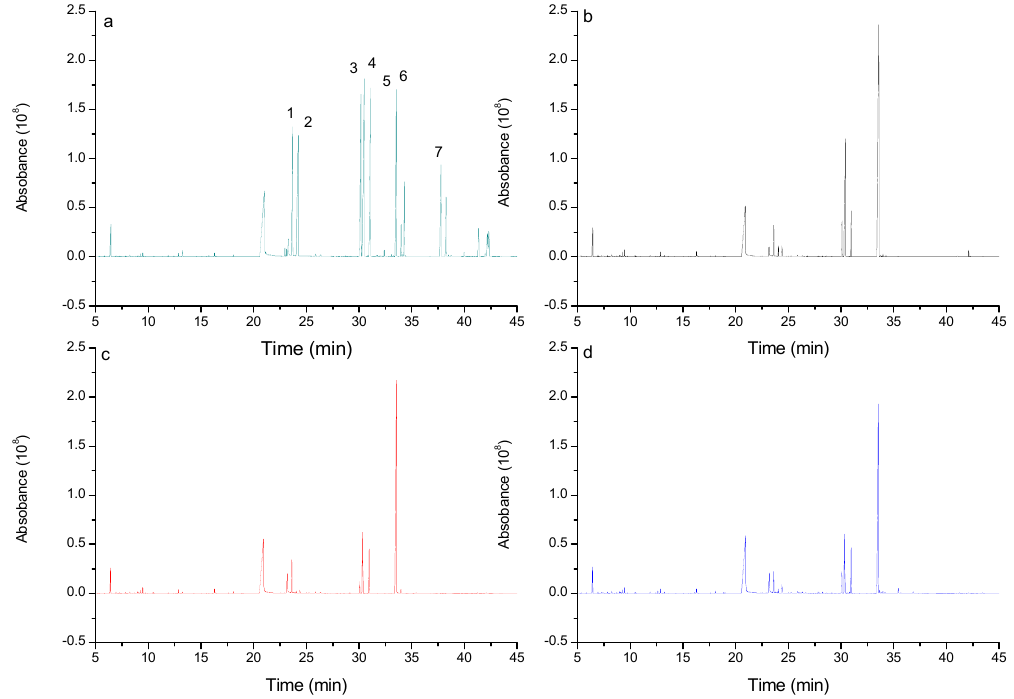
Figure 4. GC/MS profile of aldononitrile acetate derivatives of CPP1 ( b ), CPP2 ( c ), CPP3 ( d ), and monosaccharide standards (( a ); 1, Rha; 2, Ara; 3, Man; 4, Glc; 5, Gal; 6, internal standard; and 7, Fru).